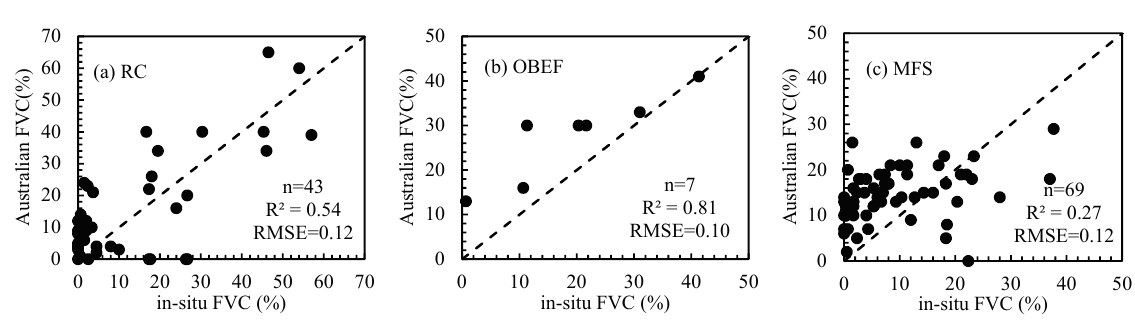
Figure 6. Scatterplots of GEOV1 FVC product with the in-situ FVC for different biome types.( a ) rainfed croplands (RC), ( b ) closed to open broadleaved evergreen forest (COBEF), ( c ) open broadleaved deciduous forest (OBDF), ( d ) closed to open shrubland (COS), ( e ) closed to open grassland (COG), and ( f ) sparse vegetation